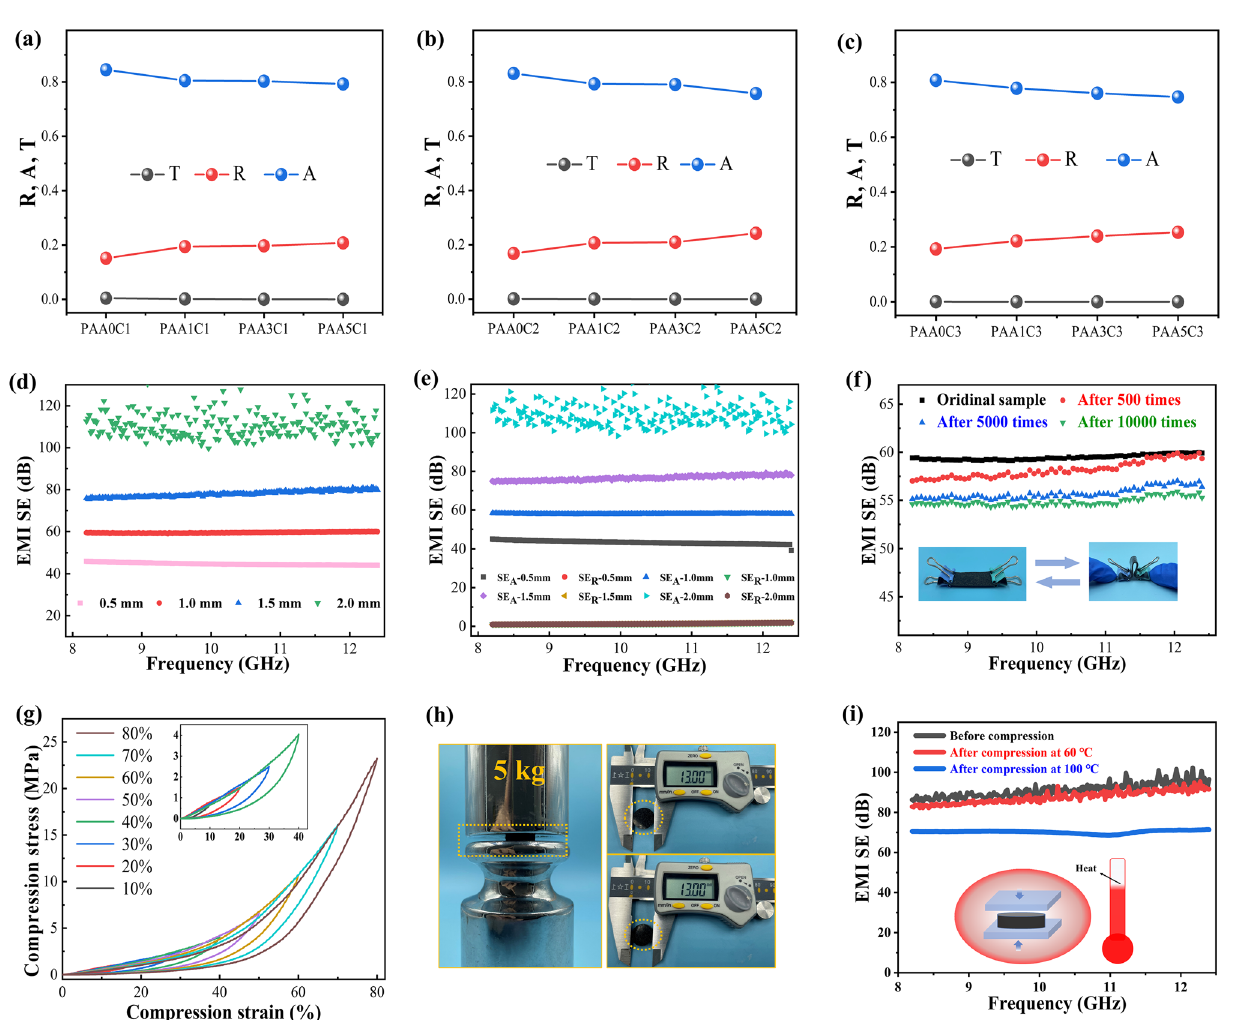
Fig. 4 The reflection coefficient ( R ), absorption coefficient ( A ) and transmission coefficient ( T ) at 10.0 GHz for a PAAxC1, b PAAxC2, c PAAxC3 composites; d EMI SE, e SE A and SE R of PAA5C3 composite with different thicknesses; f EMI SE of PAA5C3 composite before and after bending-releasing cycles with the insets showing a bending-releasing cycle; g the compression strain–stress curves of PAA5C2 composite at various strains; h Digital photograph illustrating the compression state (left) and the diameter change of the composite (right); i EMI SE of PAA5C2 composite before and after compression (load: 5 kg) at 60 and 100